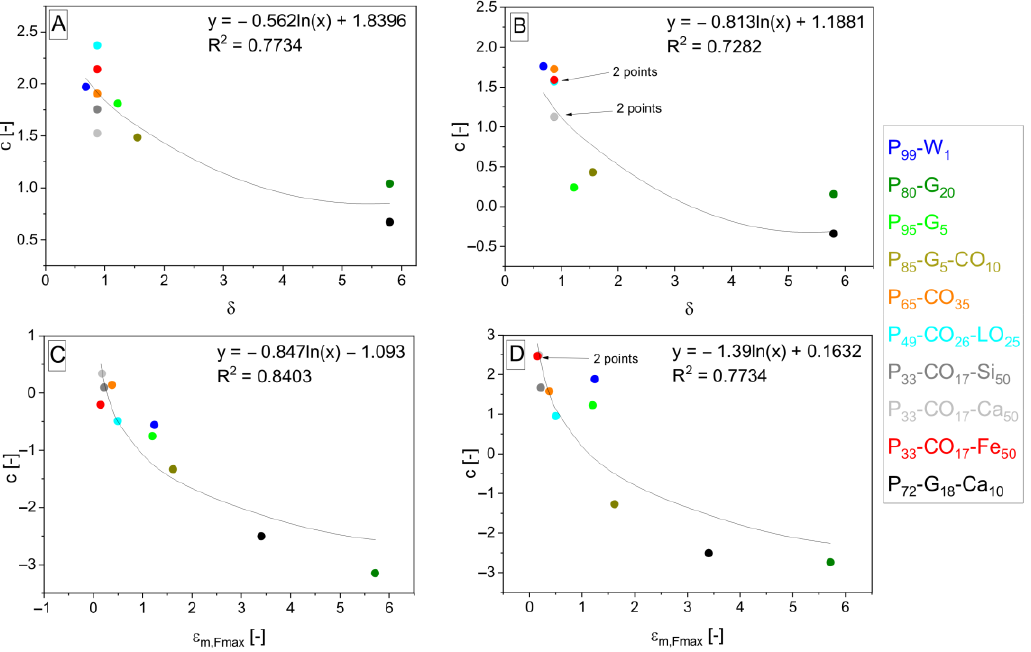
Figure 9. Logarithmic dependencies y = f + g · ln x of parameters c from general Equation (11) with different c values according to specification of property z into E ( A ), σ Fmax ( B ), ε Fmax ( C ), and A Fmax ( D ) interpolated by δ ( A , B ) and ε m,Fmax ( C , D ) values from Table 1 ( δ ) and Table 4 ( ε m,Fmax ). The resulting dependencies correspond to exponent f + g · ln x in Equations (16) – (19) arising from Equation (11) in the order from ( A ) to ( D ).